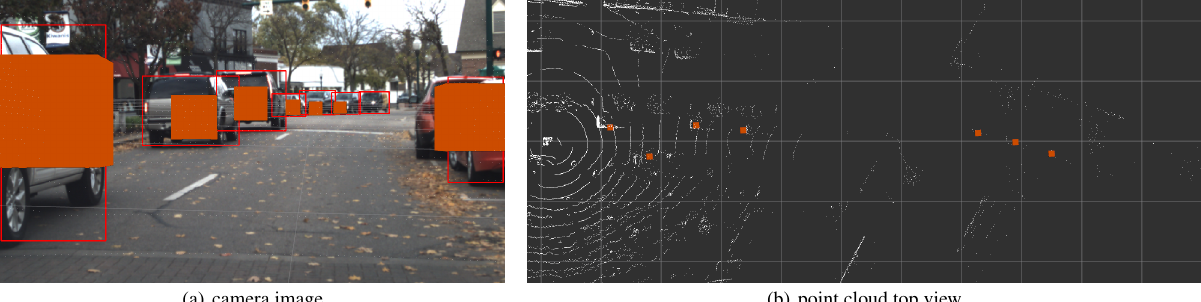
Figure 6. Object detection results for a challenging urban scenario. (a) Camera image overlayed with bounding boxes calculated by the CNN (red rectangles around vehicles) and 3D centroids projected into the image (orange cubes). (b) Top view of the Lidar point cloud (white dots) with calculated object centroids (orange cubes). Ego vehicle is located at the left boundary of the figure. Grid cells have a size of 10 by 10 meters. For the most distant car detected by the CNN no centroid was calculated since it is confirmed by only little number of Lidar